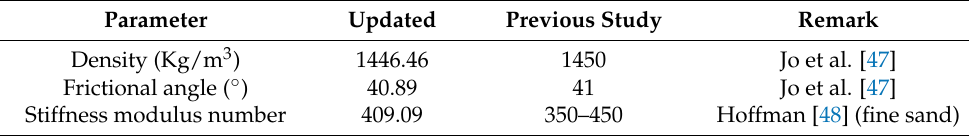
Table 6. Comparison of updated soil parameters with the previous study.